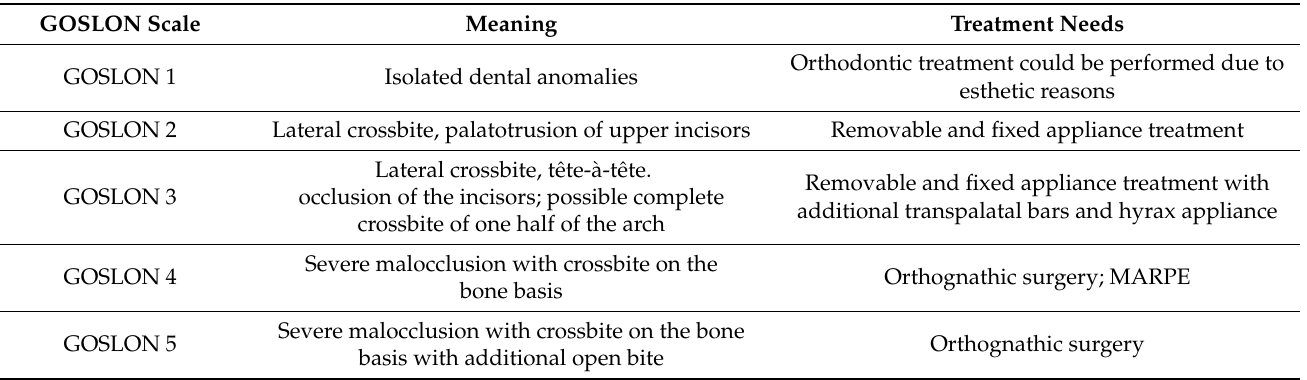
Table 1. GOSLON Index—the division, description and treatment needs